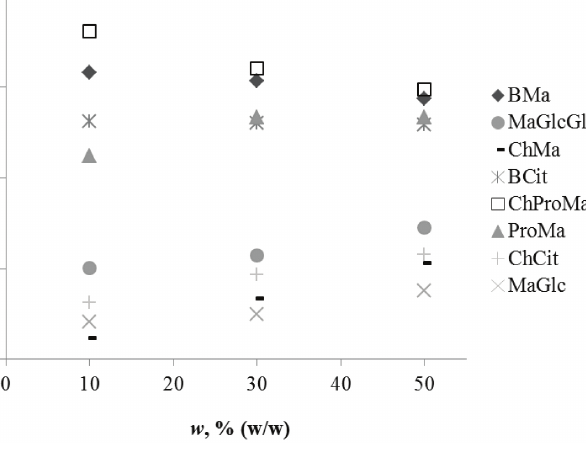
Fig. 5 – pH values of NADES as function of water content at 298